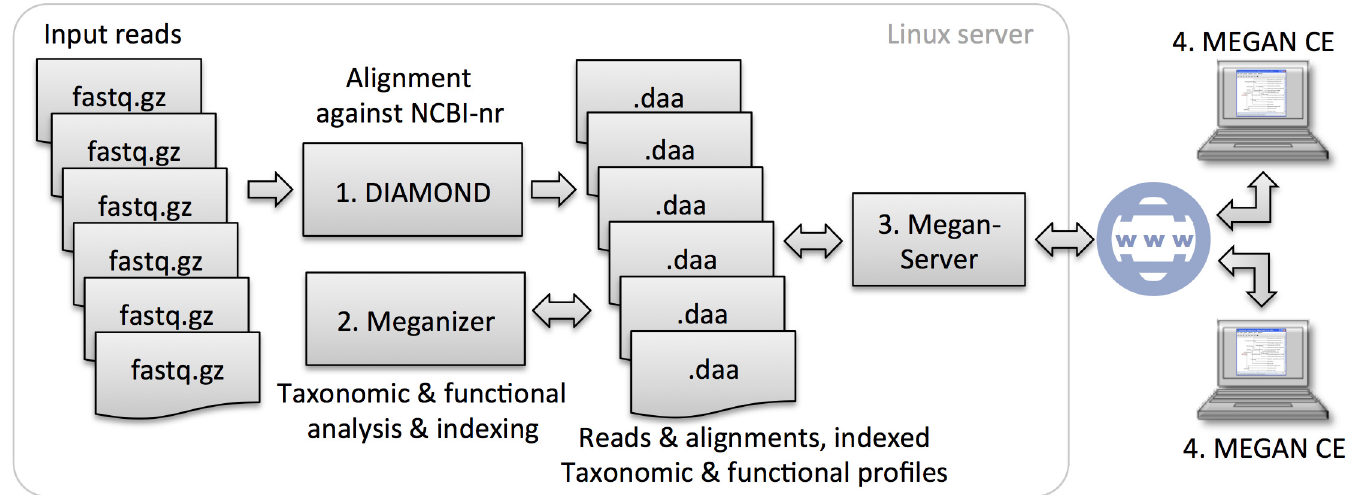
Fig 1. The compressed fastq files in a metagenome or metatranscriptome sequencing project are (1) compared against a protein reference database such as NCBI-nr using DIAMOND. (2) Taxonomic and functional analysis is then performed on the diamond files using Meganizer. (3) The resulting meganized diamond files remain on the server and are accessed via the MeganServer software. (4) Researchers work interactively with the data using MEGAN